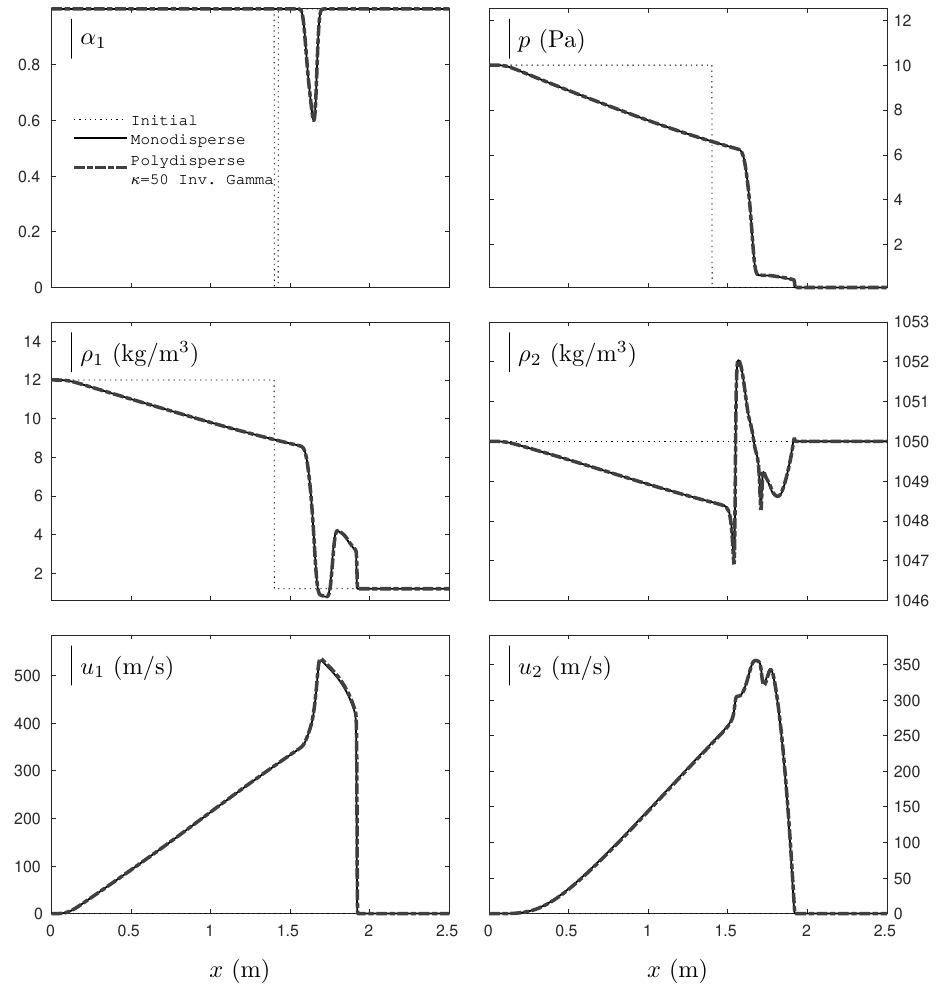
Figure 14: Simplified two-phase explosion test depicted in Fig. 5. Comparison of the monosdisperse and polydisperse results. Figure 14. Simplified two-phase explosion test depicted in Figure 5. Comparison of the monodisperse The initial mean radius is the same for both computations R 2 t =0 = R t =0 2 = 30 µ m. For the polydisperse computation, the and polydisperse results. The initial mean radius is the same for both computations R 2 Inverse Gamma distribution is used with κ = 50. All results are given at time t = 1 . 2 ms and are presented in terms of α 1 , p , 30 µ m. For the polydisperse computation, the Inverse Gamma distribution is used with κ = 50. All ρ 1 , ρ 2 , u 1 and u 2 for both computations. The two solutions are very close. results are given at time t = 1.2 ms and are presented in terms of α 1 , p , ρ 1 , ρ 2 , u 1 and u 2 for both computations. The two solutions are very